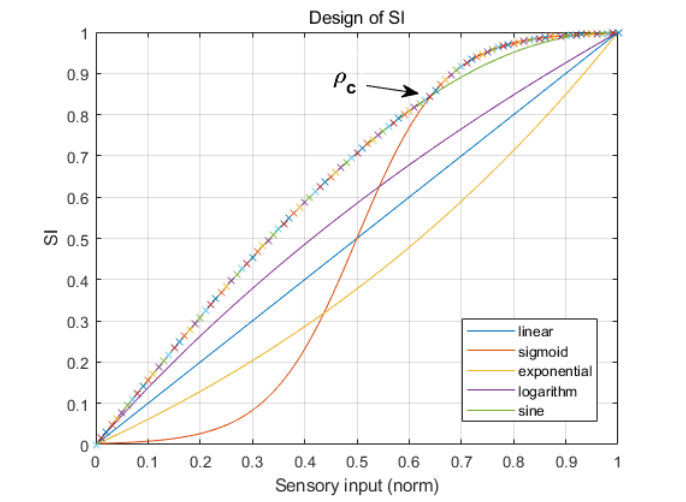
Figure 4. Functions for design SI